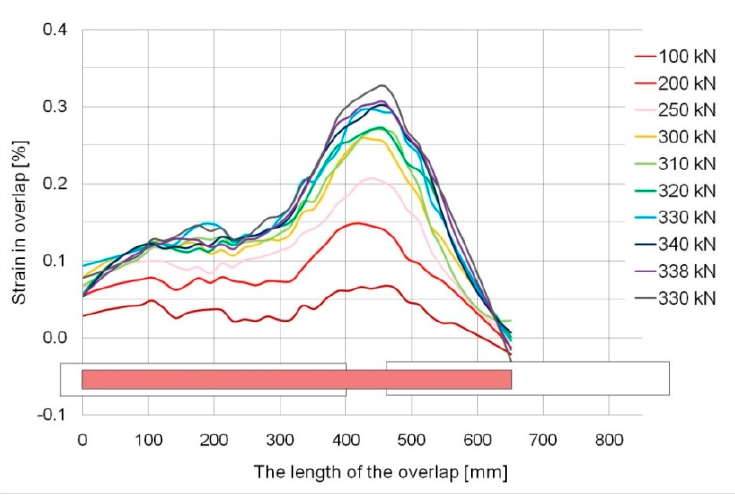
Figure 14. Strains determined over the whole overlap length, specimen S/DL/MA/RS-200-4/P2.